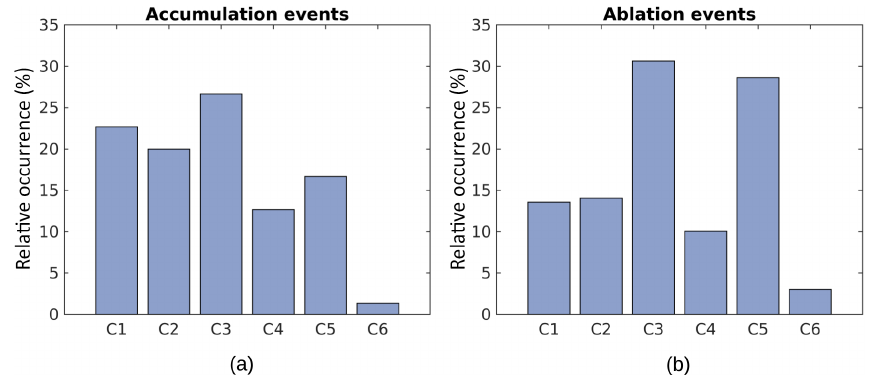
Figure 8. Frequency of occurrence of the circulation patterns depicted in Fig. 3 for wind-induced accumulation (a) and ablation (b) without